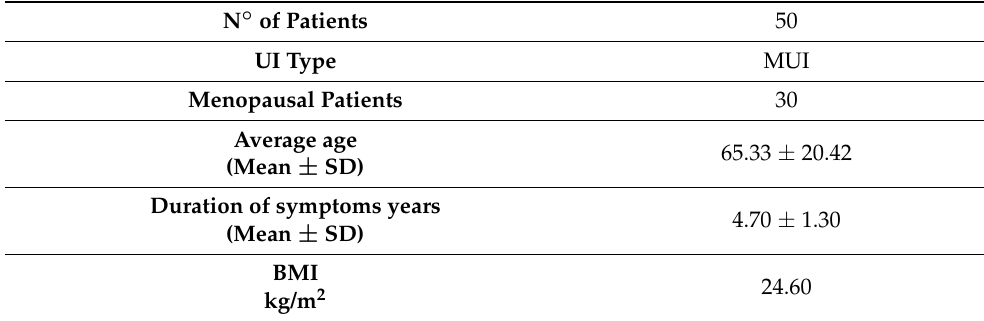
Table 1. Demographic Characteristics of